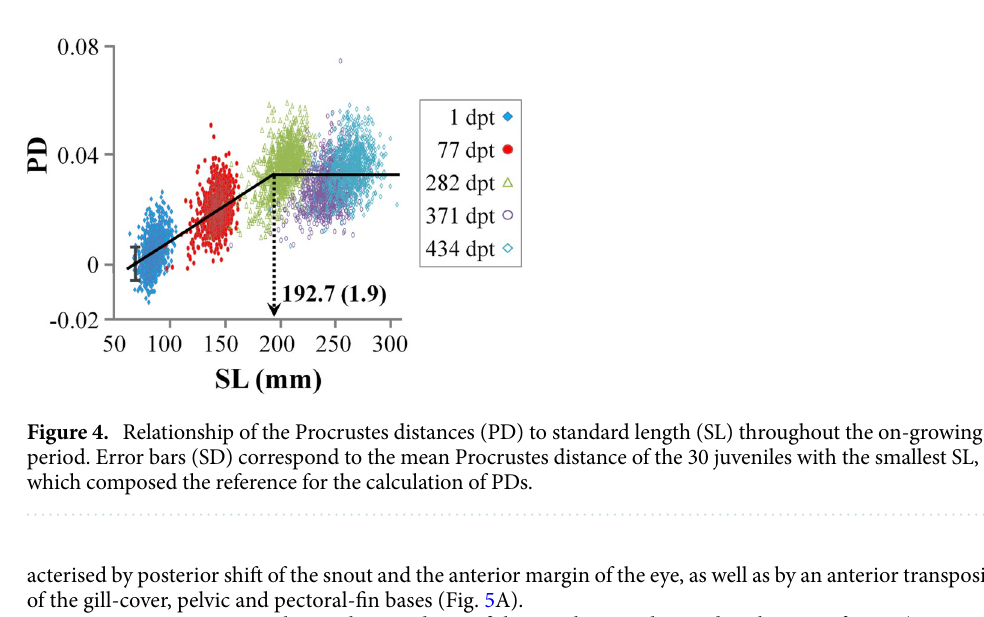
Figure 3. ( A ) Pearson’s correlation coefficients between the relative warps (RW) of the juvenile stage (1 dpt) with the RWs of the next sampling points, up to the end of the on-growing period (434 dpt). ( B ) Pearson’s correlation coefficients between the relative warps (RW) at the end of on-growing (434 dpt) with the RWs of the previous sampling points, up to the beginning of on-growing period (1 dpt). Correlation coefficients were estimated for the first six relative warp scores which explain the 80.1% of total body-shape variance. Numbers in brackets give the variance explained by each RW. All estimated correlations were significant ( P < 0.05).